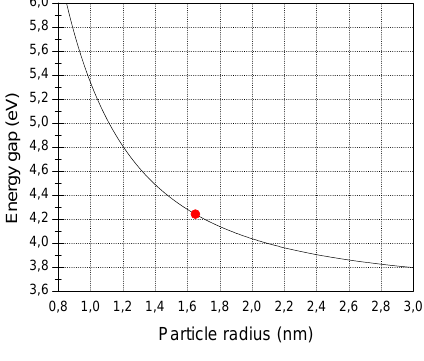
nanoparticle energy gap vs. particle radius. The dot represents 2 =4.24 g